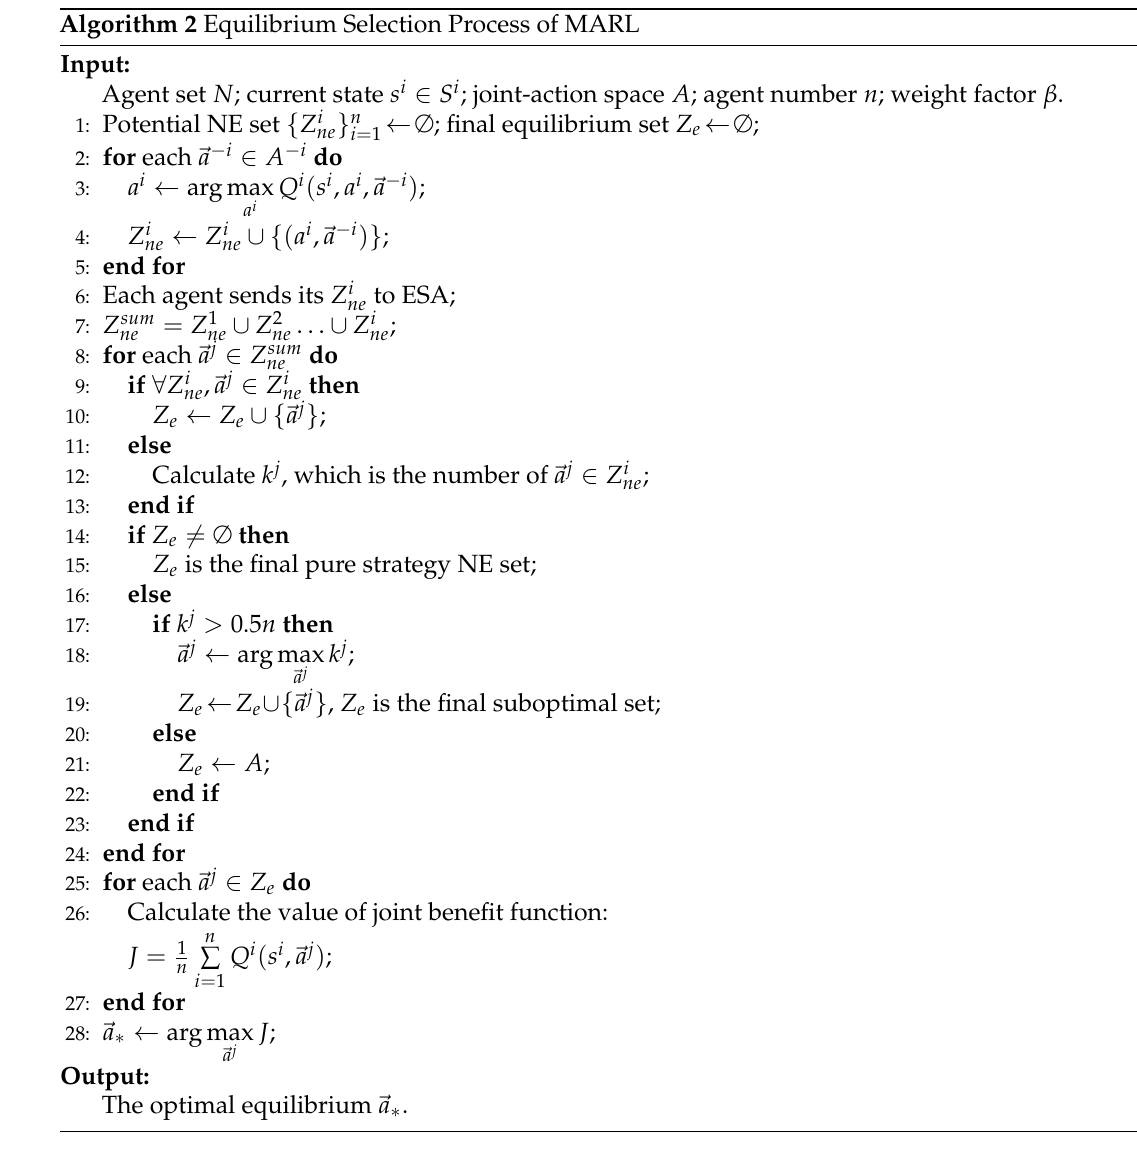
Algorithm 2 Equilibrium Selection Process of